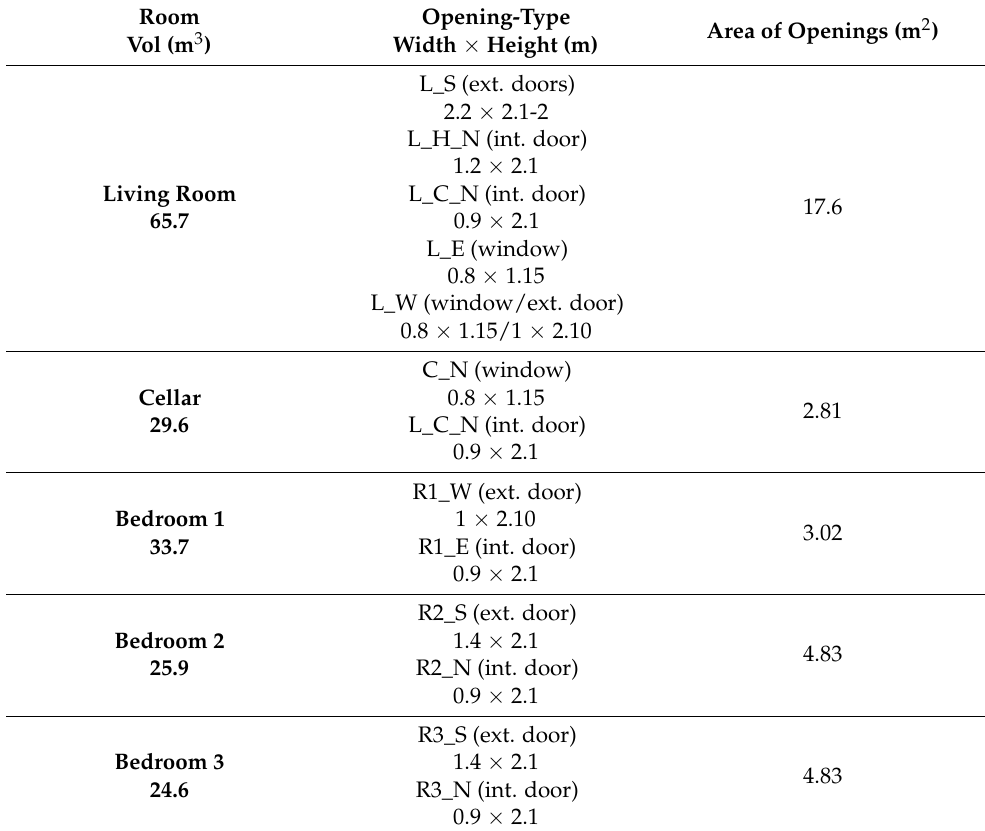
Table 1. Overview of spaces details in the case-study building.